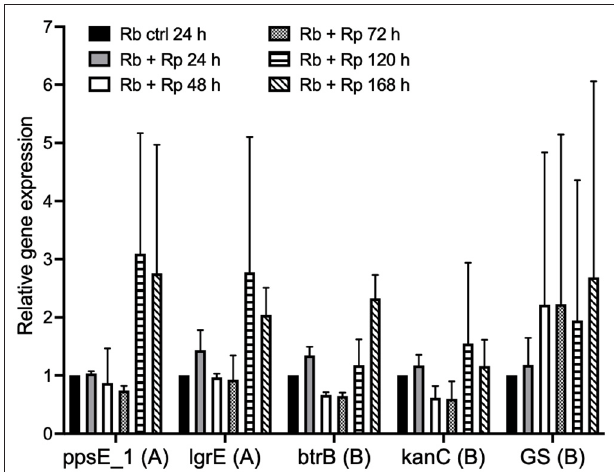
FIGURE 8 | Expression of R. buchneri antibiotic cluster genes in response to Rickettsia parkeri challenge. Relative expression of R. buchneri antibiotic cluster genes in response to R. parkeri- mKate challenge over 7 days. Bars show the expression of each gene relative to the control (unchallenged R. buchneri ) as the mean and standard deviation of two independent experiments for each qRT-PCR assay. Ct values were normalized to GAPDH expression in infected IRE11 cells. Genes from the polyketide and aminoglycoside clusters are denoted by (A) and (B), respectively. Means were compared to the unchallenged control using a two-way ANOVA with Dunnett’s multiple-comparison